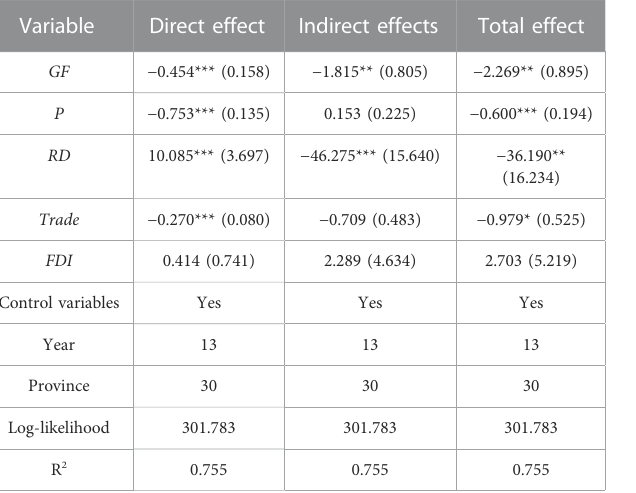
TABLE 6 Regional heterogeneity test for the impact of green fi nance on energy